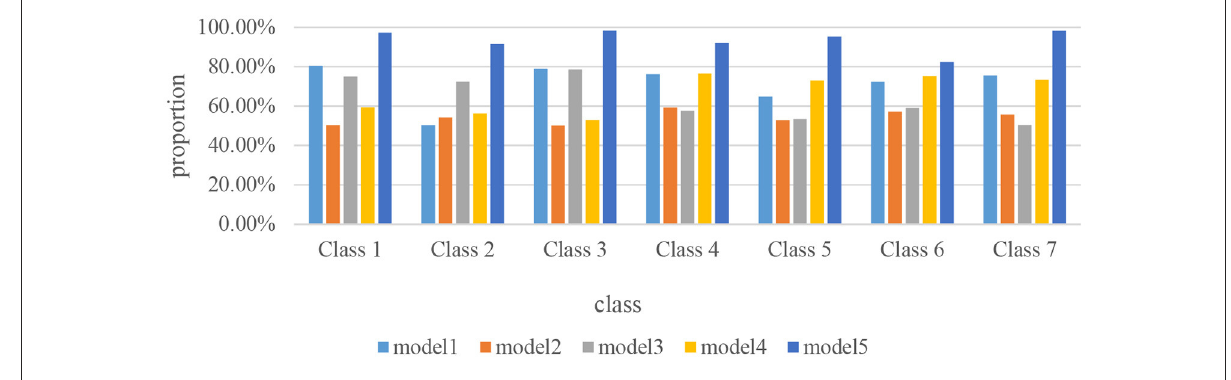
FIGURE10 Score rate of student history under different teaching